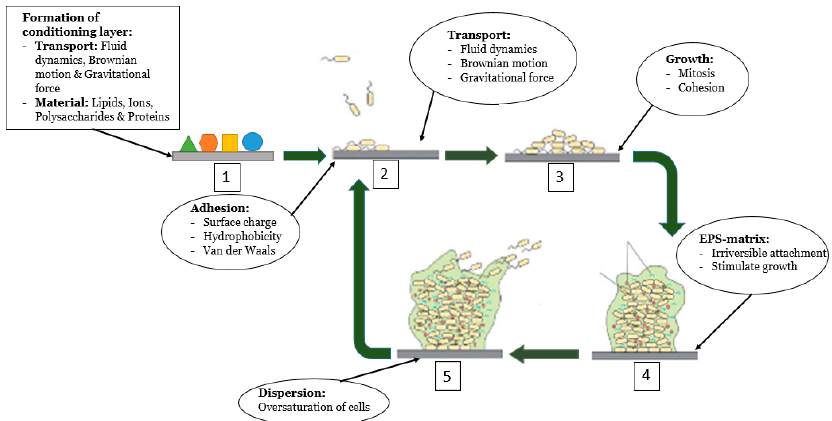
Figure 1. A visualization of the five phenomena of biofilm formation. The figure indicates the conditions of the medium and the specific surface on which microbial adhesion occurs; the initial adherence of microorganisms to the surface; the proliferation (or else microcolony formation); and the maturation of the biofilm architecture with the presence of the polymeric matrix and its dispersion [7,9].